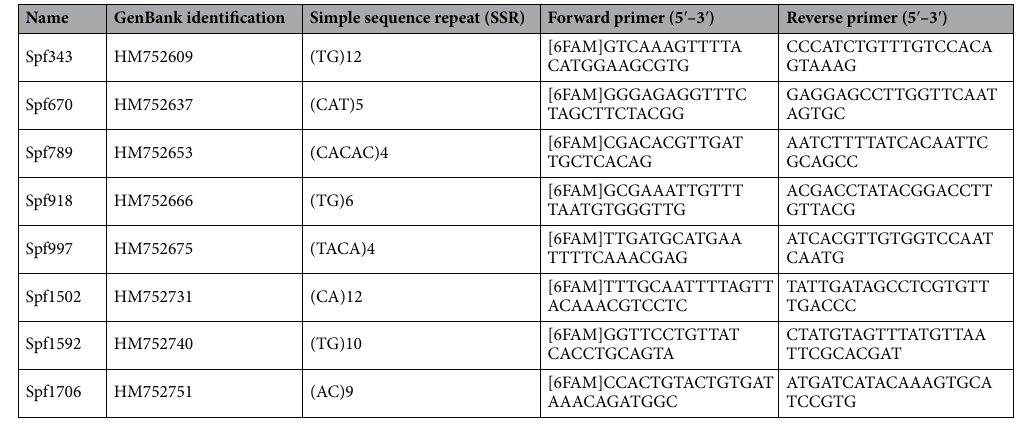
Table 5. Microsatellite primer